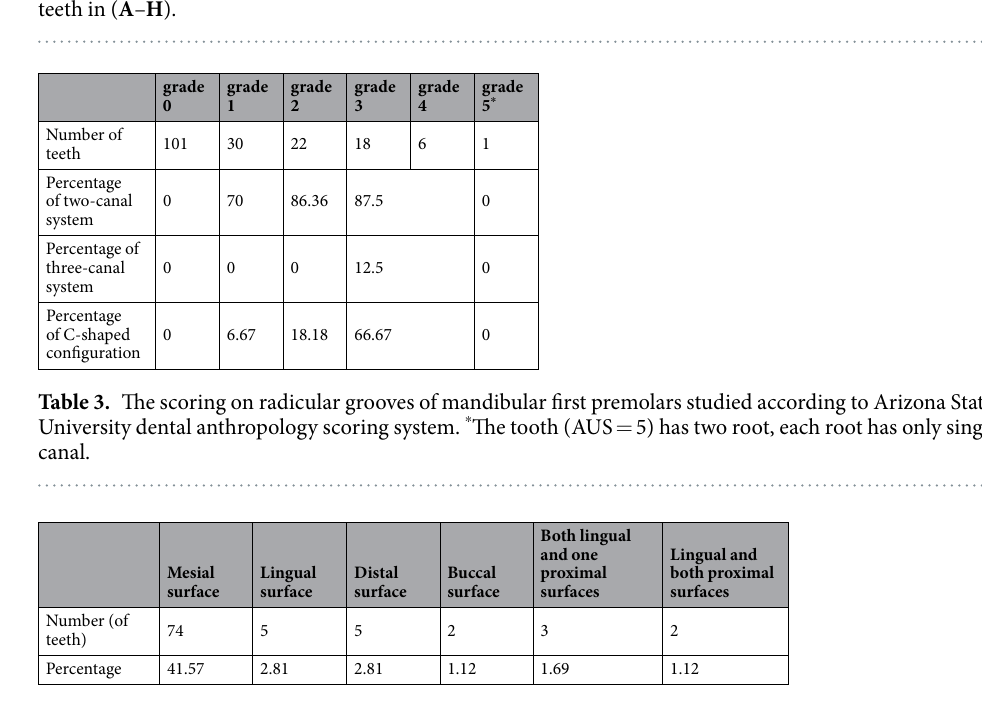
Table 4. The distribution of the radicular grooves in mandibular first